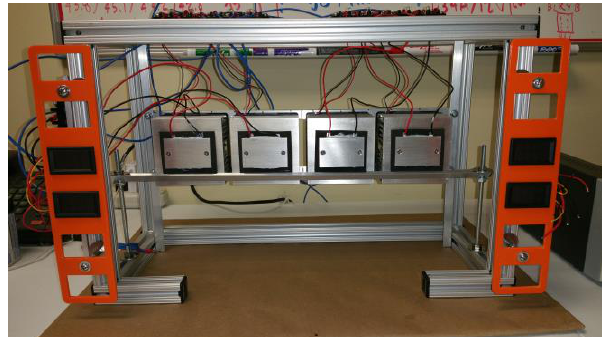
Figure 2: Original 4 TEC Platform